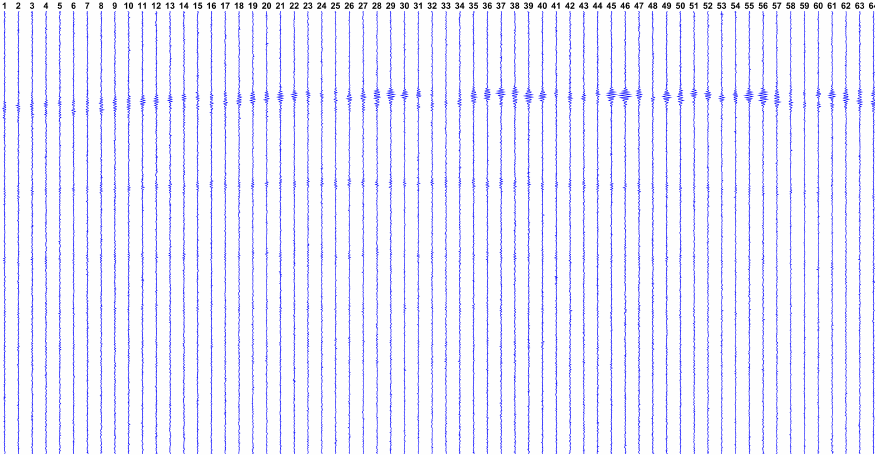
Figure 9. The synthetic dataset g synt = Hf synt + e . Each vertical line represents the dataset from a single transducer, over time t i (increasing from top to